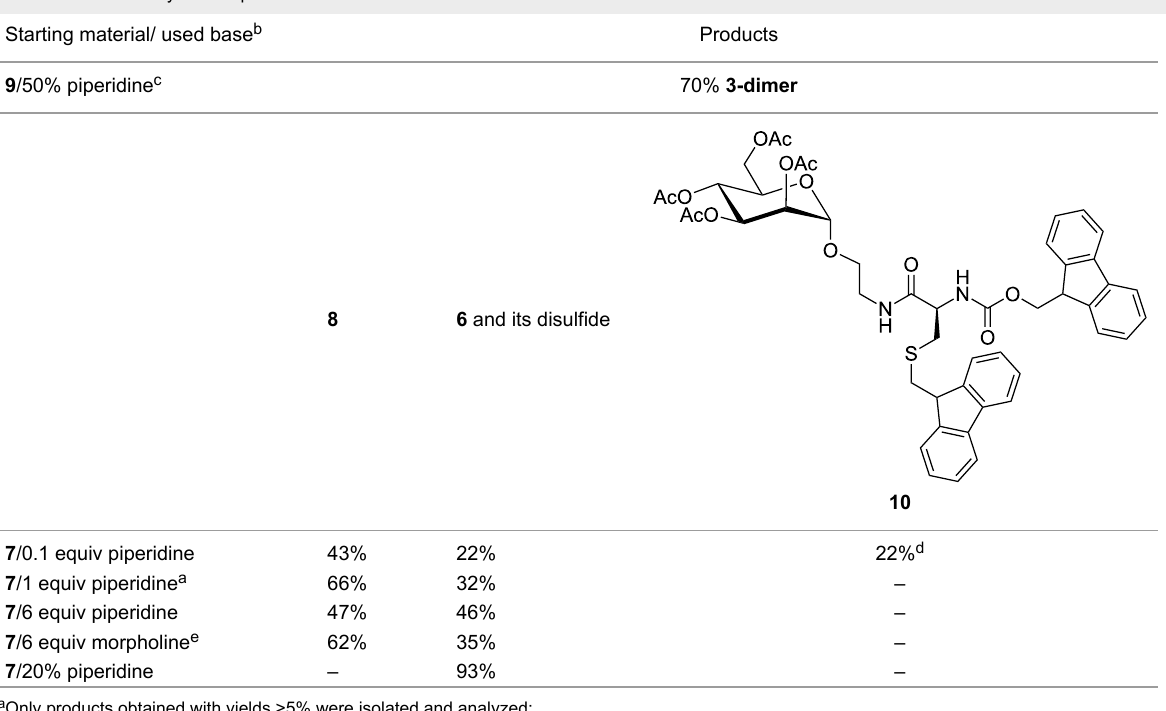
Table 1: Product analysis of deprotection reactions under different basic reaction conditions.